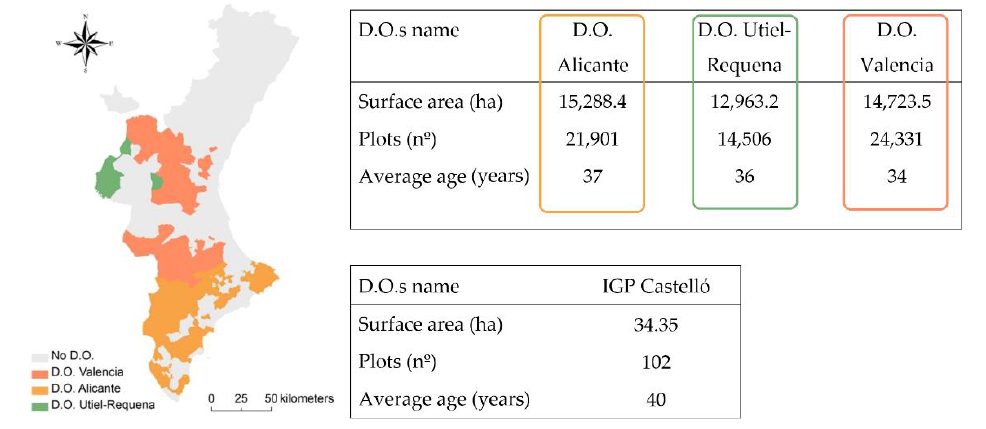
Figure 7. Denomination of origin (DO) in the Valencian community and selected indicators.